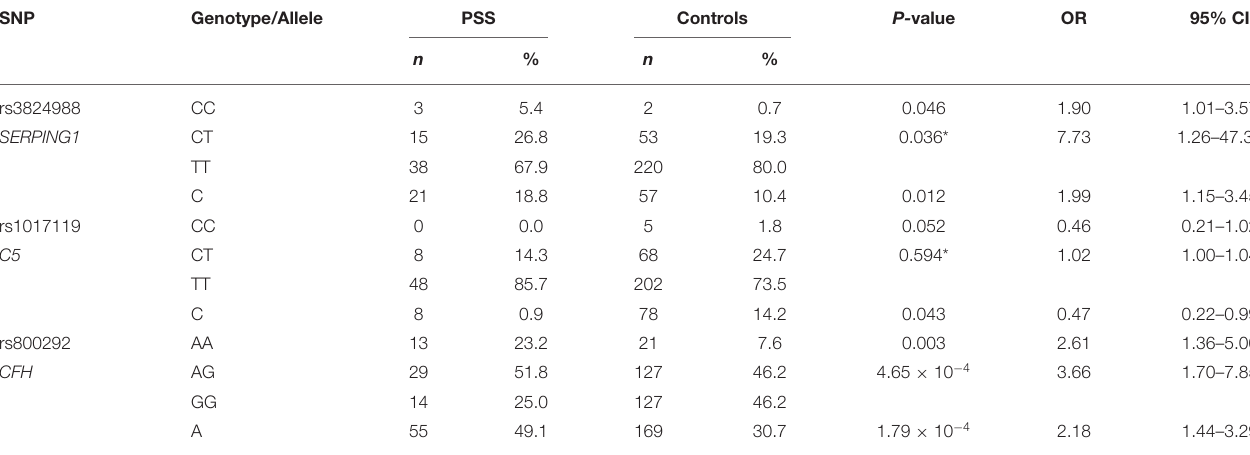
TABLE 3 | Genotypic association of rs3824988, rs1017119, and rs800292 in PSS patients and healthy controls.